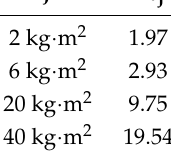
Table 2. Time constants depending on virtual inertia values.